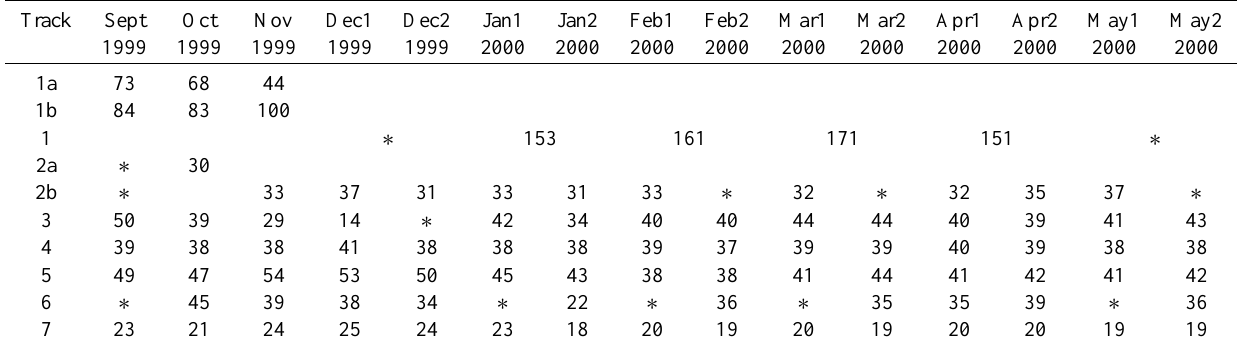
Table 2. Period and number of XBT launches done during MFSPP. Star indicates that the track was not carried out. The sampling frequency was approximately 15 days for tracks 2,3,4,5,6,7 and one month for track 1. The number 1 near the names of the month indicates that the data were collected in the first half of the month, while number 2 indicates that the data were collected in the second half Track